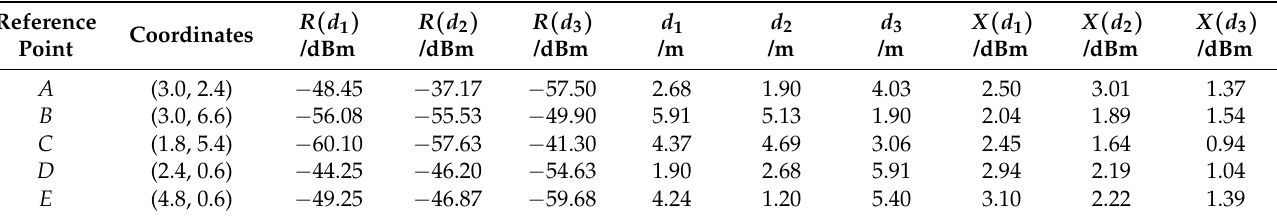
Table 1. Measurement data of reference points.